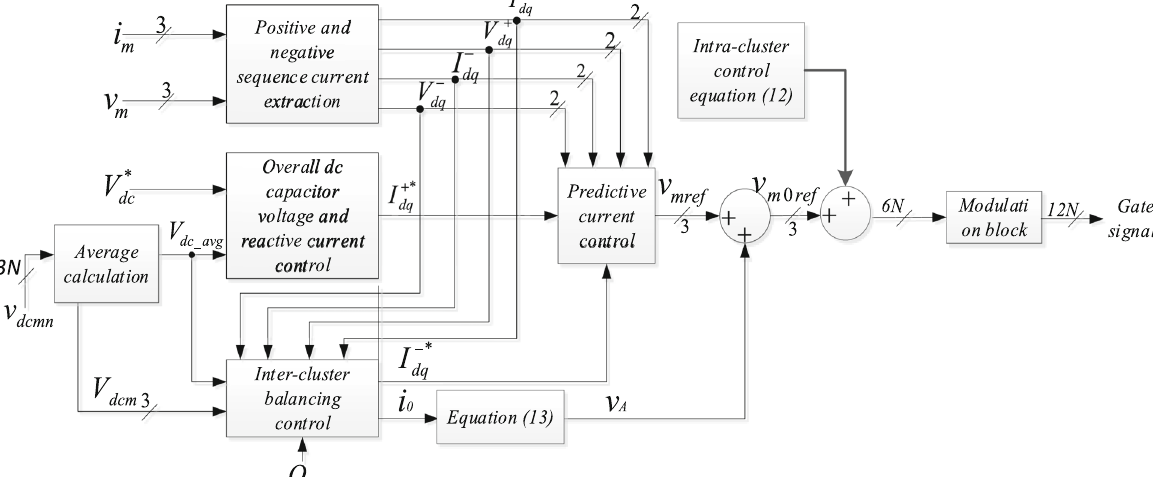
Fig. 2 Control block diagram of MMCC-STATCOM under unbalanced voltage